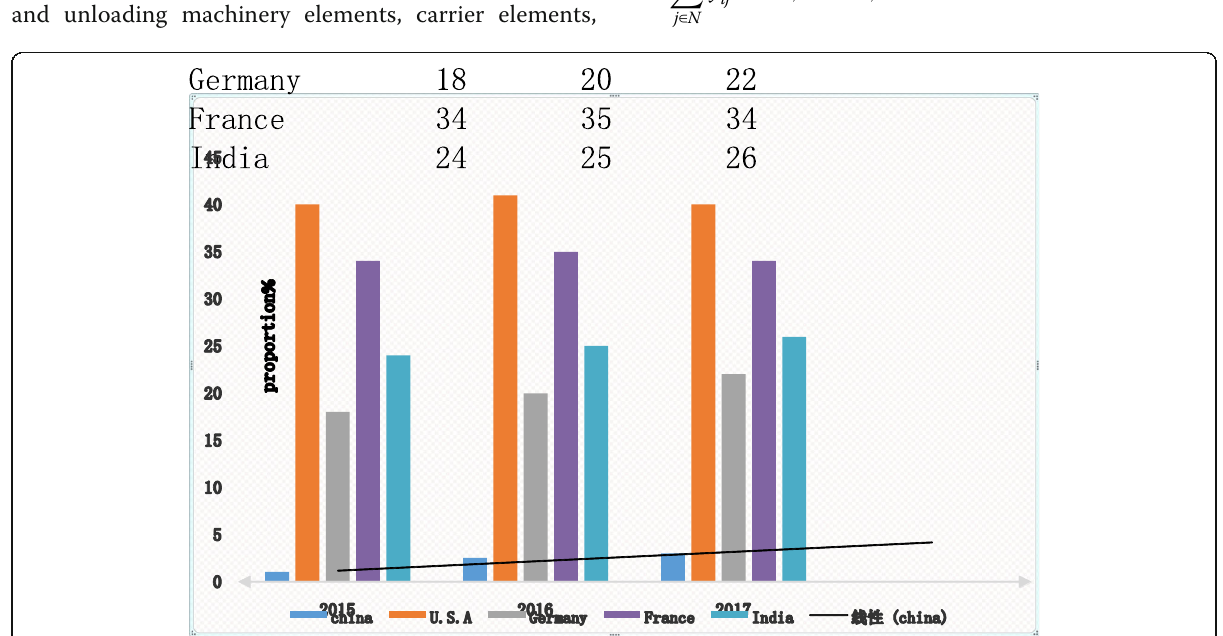
Fig. 1 The proportions of the combined transport of container railways and waterways in China and other countries around the